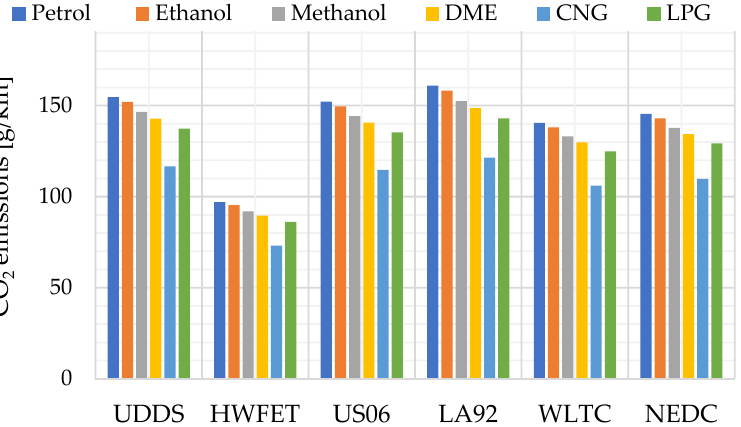
Figure 15. Summary of final CO 2 emissions per kilometer travelled obtained from the simulation of the 2018 Toyota Camry LE vehicle for selected road tests.